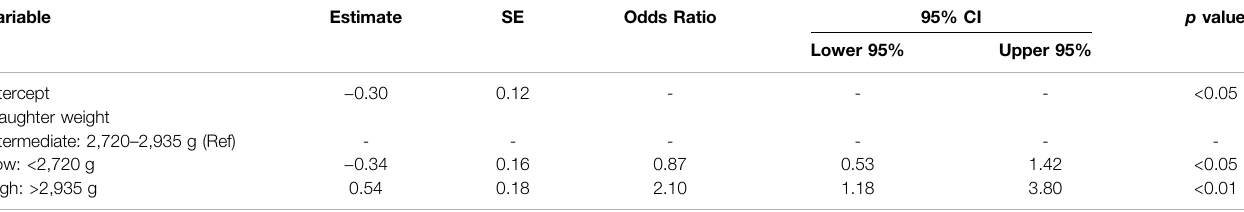
TABLE 6 | Factors in fl uencing spaghetti meat occurrence in female broiler chickens and extracted by forward selection in the multivariate logistic regression analysis. Variable